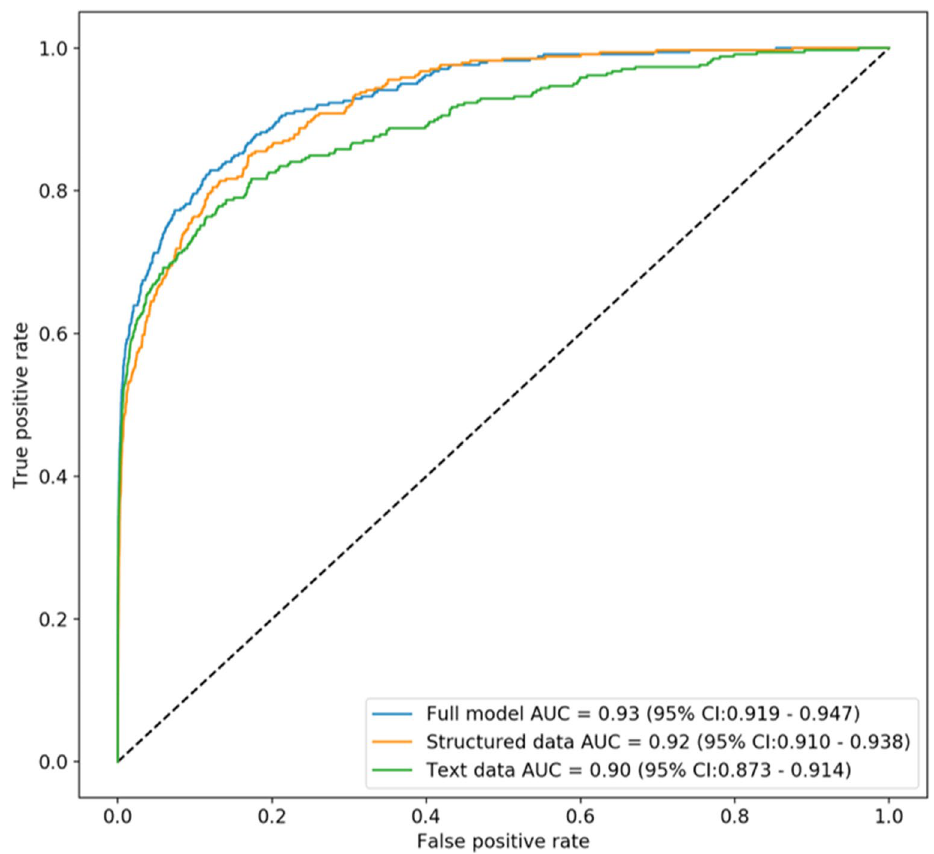
Figure 4. Receiver-operating curve for all 3 models. Combined model performance is illustrated in blue, tabular data-only model performance in orange, and text-only model in green. AUC area under receiver- operating curve.